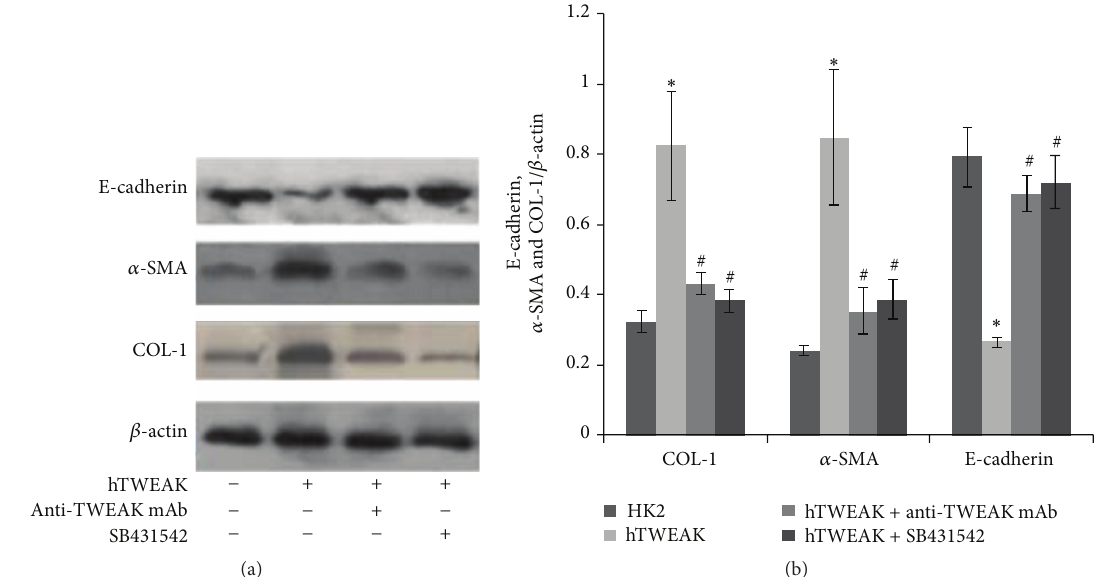
Figure 6: Effects of SB431542 on hTWEAK induced expressions of 𝛼 -SMA, COL-1, and E-cadherin proteins in HK2 cells. Total cell lysates were collected for Western blotting to measure 𝛼 -SMA, COL-1, and E-cadherin protein expressions. The representative experiment was presented in (a). The ratios of 𝛼 -SMA/ 𝛽 -actin IOD, COL-1/ 𝛽 -actin IOD, and E-cadherin/ 𝛽 -actin IOD were shown in (b). HK2: HK2 cells cultured without stimulation; hTWEAK: HK2 cells cultured with hTWEAK; hTWEAK+anti-TWEAK mAb: HK2 cells cocultured with hTWEAK and anti-TWEAK mAb; and hTWEAK+SB431542: HK2 cells cocultured with hTWEAK and SB431542. The error bars represent the standard deviation. Each experiment was repeated at least 3 times. ∗ 𝑝 < 0.01 versus HK2 cells cultured without stimulation and # 𝑝 < 0.01 versus HK2 cells cultured with